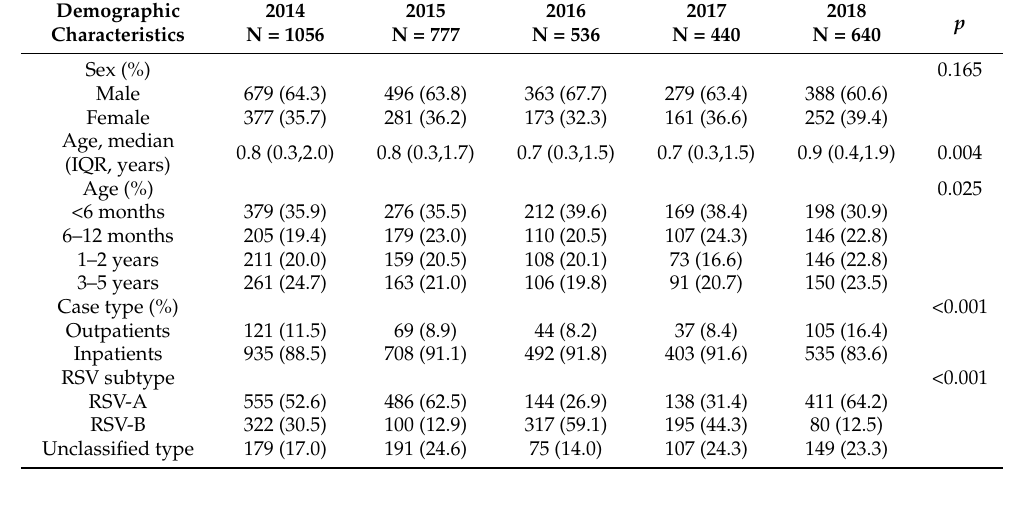
Table 1. Demographic characteristics of study participants by year.